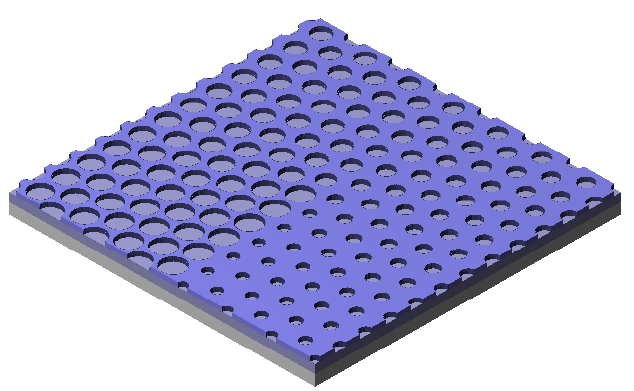
Figure 5. 3D conceptual drawing of an azimuthally varying hexagonal GMRF. The hexagonal period, the SWG thickness, and the waveguide thickness are all uniform; however, the fill fraction of the lattice varies with the azimuth angle.